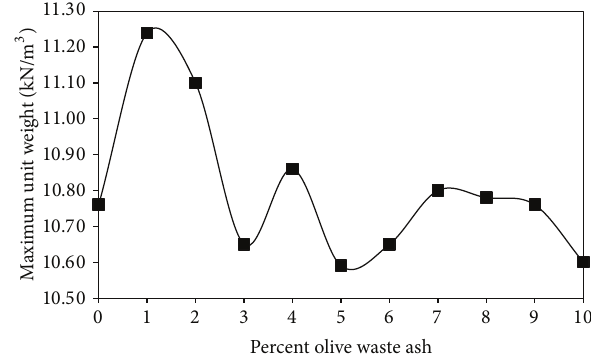
Figure 2: Effect of olive waste ash on the specific gravity.